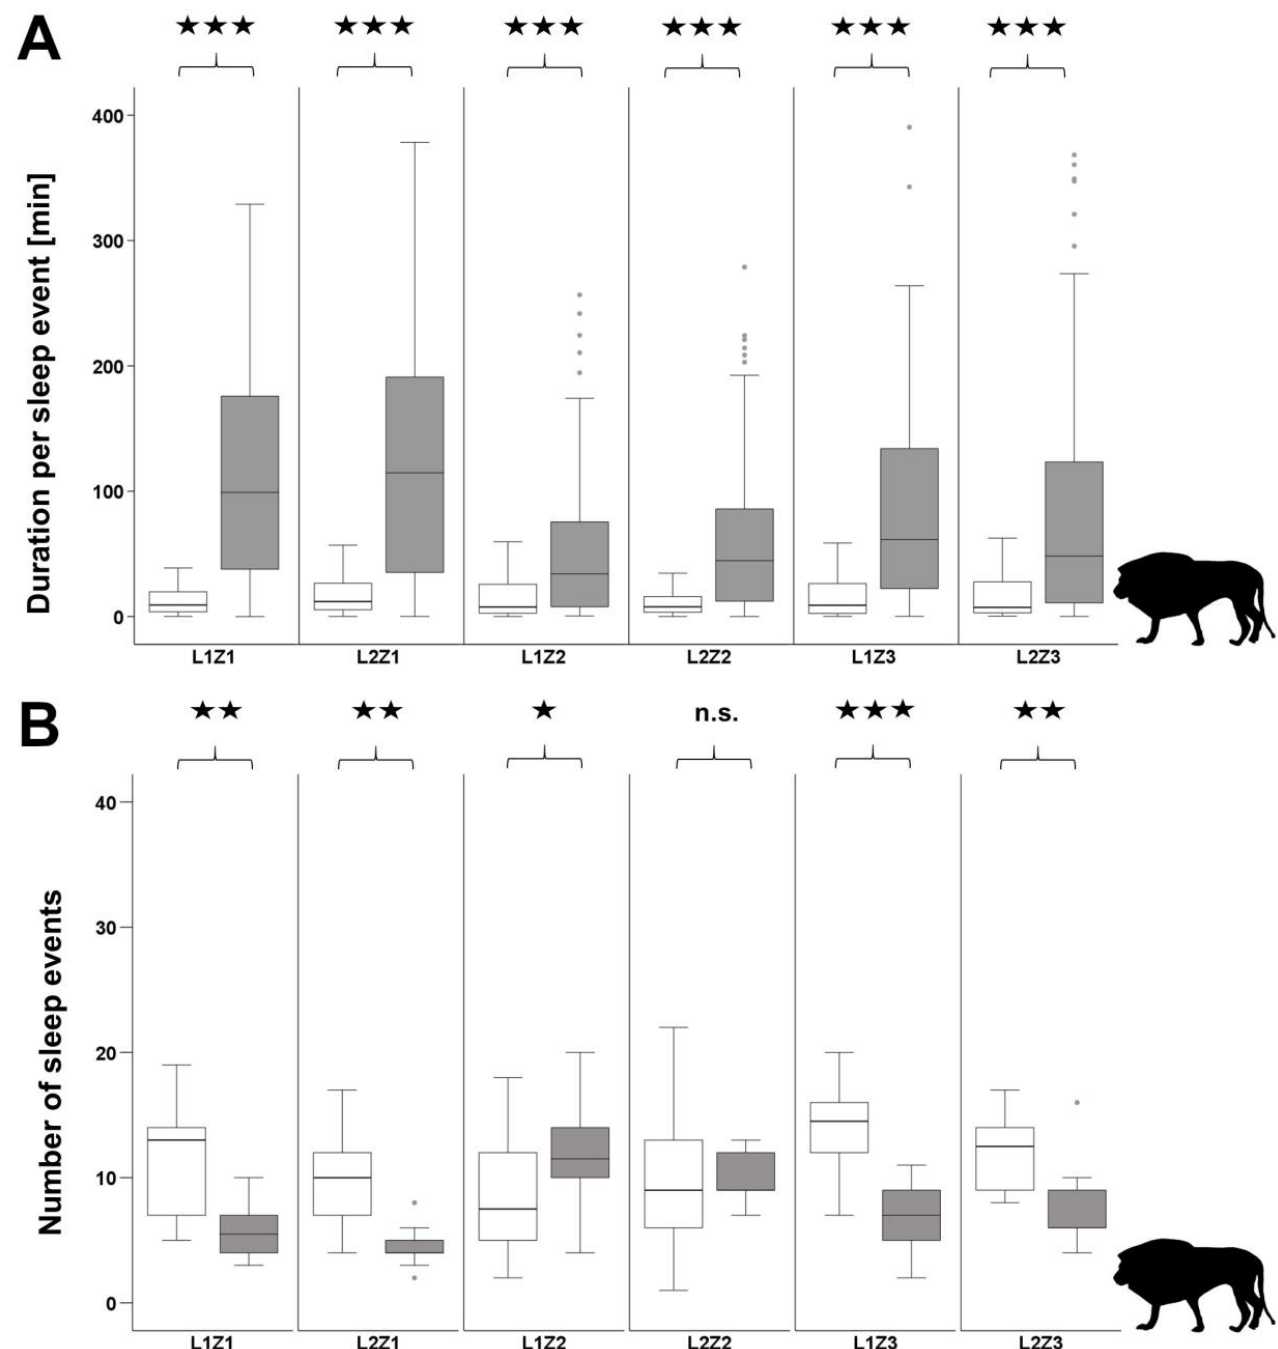
Figure 3. Diurnal (7 a.m.–7 p.m.) and nocturnal (7 p.m.–7 a.m.) sleep patterns of lions. ( A ) Duration per sleep event and ( B ) Number of sleep events per day (white boxes) and per night (grey boxes); n.s. > 0.05; * p < 0.05; ** p < 0.01; *** p < 0.001) over the total observation period.